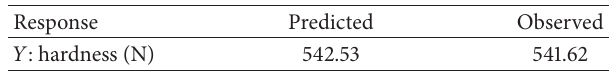
Table 5: Predicted and observed values for the optimised formula-